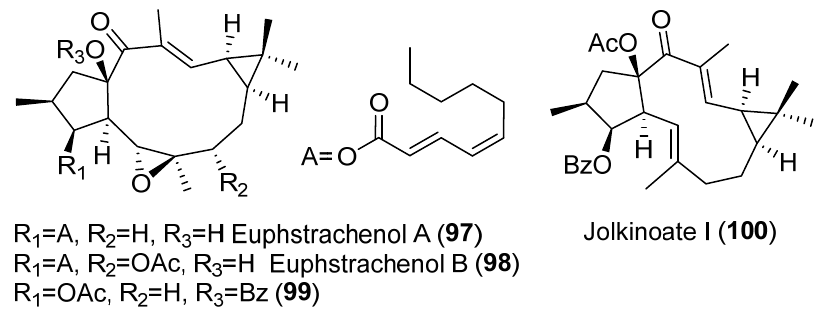
Figure 15. Cytotoxic lathyrane-diterpenes ( 97 – 100 ) from E. stracheyi. The cytotoxic activity of ingol-type diterpenes has also been evaluated. 3,12-diacetyl-7-angeloyl-8-methoxyingol ( 101 ), 7-angeloyl-12-acetyl-8-methoxyingol ( 102 ) and 3,12-diacetyl-7-hydroxy-8-methoxyingol ( 103 ) (Figure 16), isolated from E. nivulia , showed significant cytotoxic activity against Colo 205, MT2 and CEM cell lines, although some ingol derivatives had little or no activity [48].